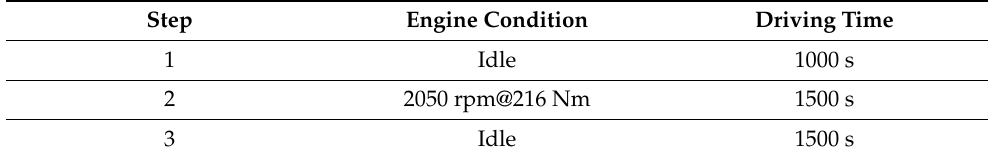
Table 3. Engine operating modes.